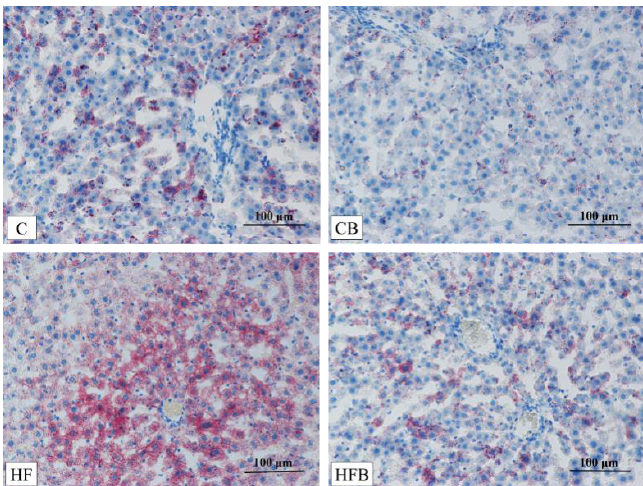
Figure 3. The results of betaine and high-fat diet on lipid deposition in liver of rats (200 × ). C—basal diet, CB—basal diet supplemented with 1% betaine, HF—high fat diet, HFB—high fat diet supplemented with 1% betaine.